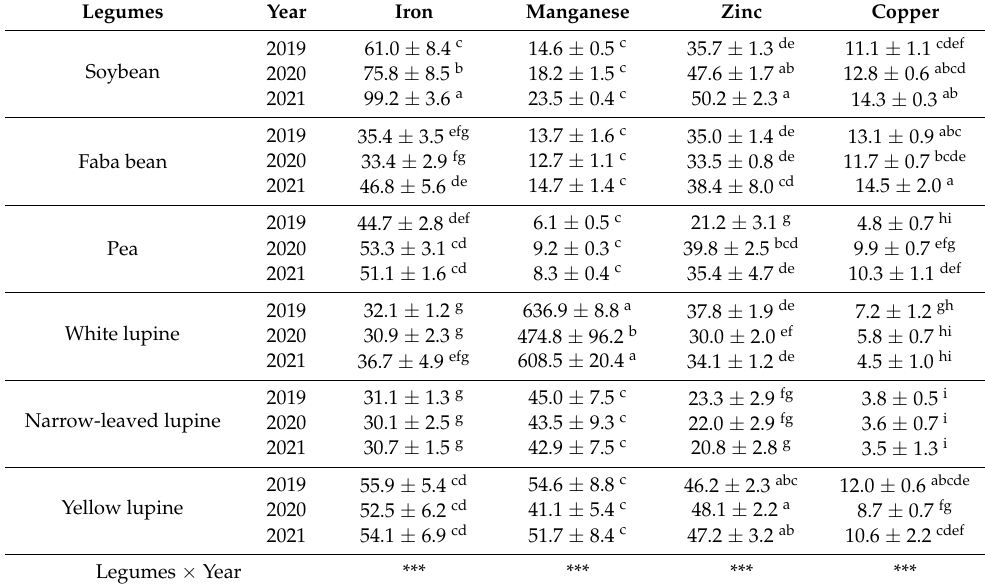
Table 4. Micronutrient contents in seeds (mg kg − 1 DM).